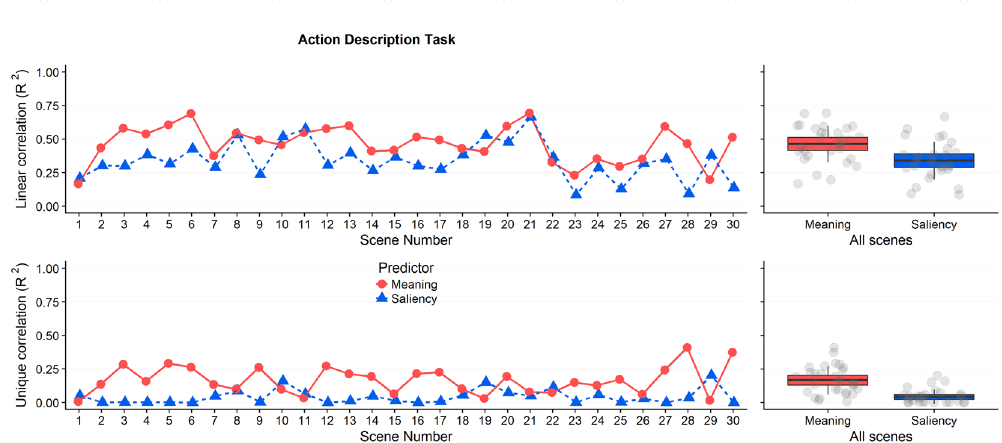
Figure 3. Squared linear correlation and semi-partial correlation by scene and across all scenes in Experiment 1. The line plots show the linear correlation (top) and semi-partial correlation (bottom) between fixation density and meaning (red) and salience (blue) by scene. The scatter box plots on the right show the corresponding grand mean (black horizontal line), 95% confidence intervals (colored box), and 1 standard deviation (black vertical line) for meaning and salience across all 30